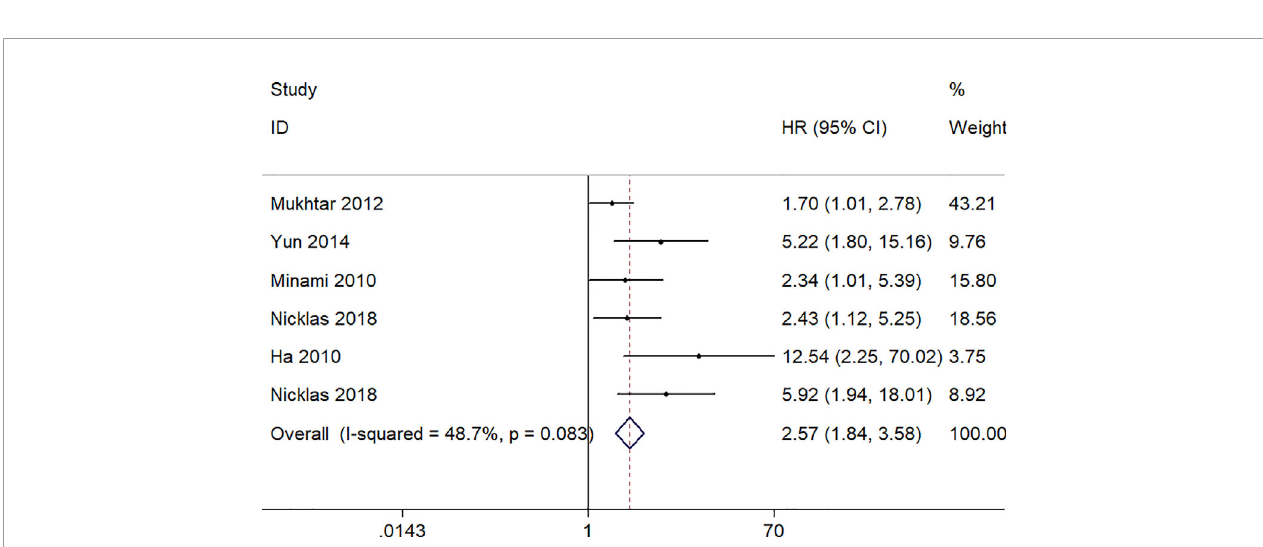
FIGURE 3 | Forest plot of studies evaluating hazard ratios of S100A8 overexpression and the disease-free survival of cancer patients.